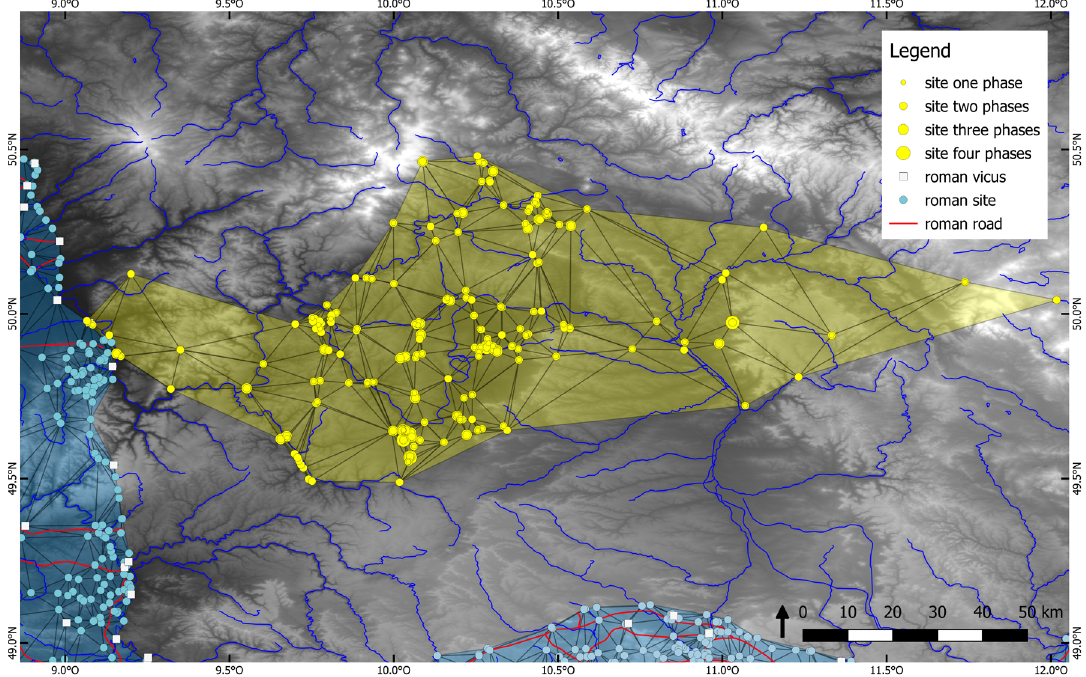
Figure 8. Sites dating to the Early Roman Iron Age II (Eggers Phase B2, 60-180 AD) in yellow. In contrast to the Early Roman Iron Age I (Eggers Period A-B1, 15 BC to 70 AD) in Fig. 3, now Romans and Barbarians are not divided by a settlement empty borderland in the hills of the Spessart region as before. The contact zone to the roman world is still very small indicated by new sites in the Barbarian west. Sources: see Fig. 3, GIS